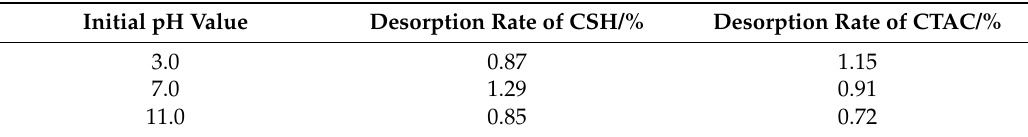
Table 3. The desorption results of organic modifiers from organomontmorillonite (OMt) under different initial pH value.